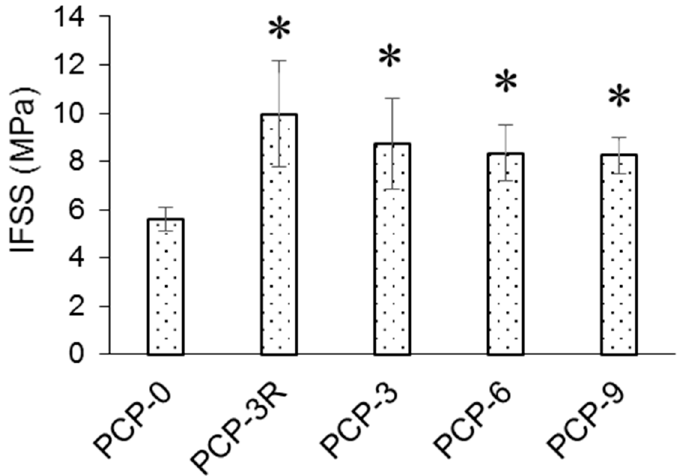
Figure 2. Interfacial shear strength (IFSS) obtained from fragmentation tests ( n = 10). The statistical significance of the paired t -test at p < 0.05 was illustrated (*) compared to PCP-0.